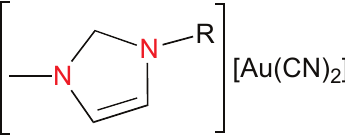
C H OC H 2 6 4 12 25